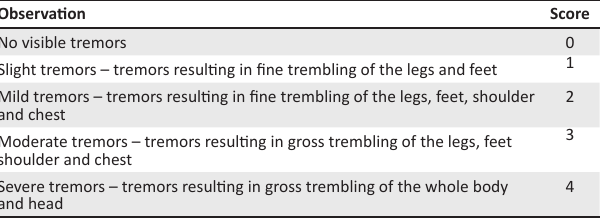
TABLE 1: Scoring system used to rank tremor intensity in the rhinoceros based on visual observations. Observation Score No visible tremors